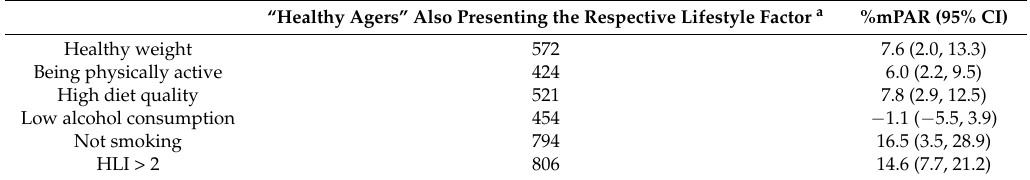
Table 4. Modified population attributable risks (mPARs) according to individual lifestyle